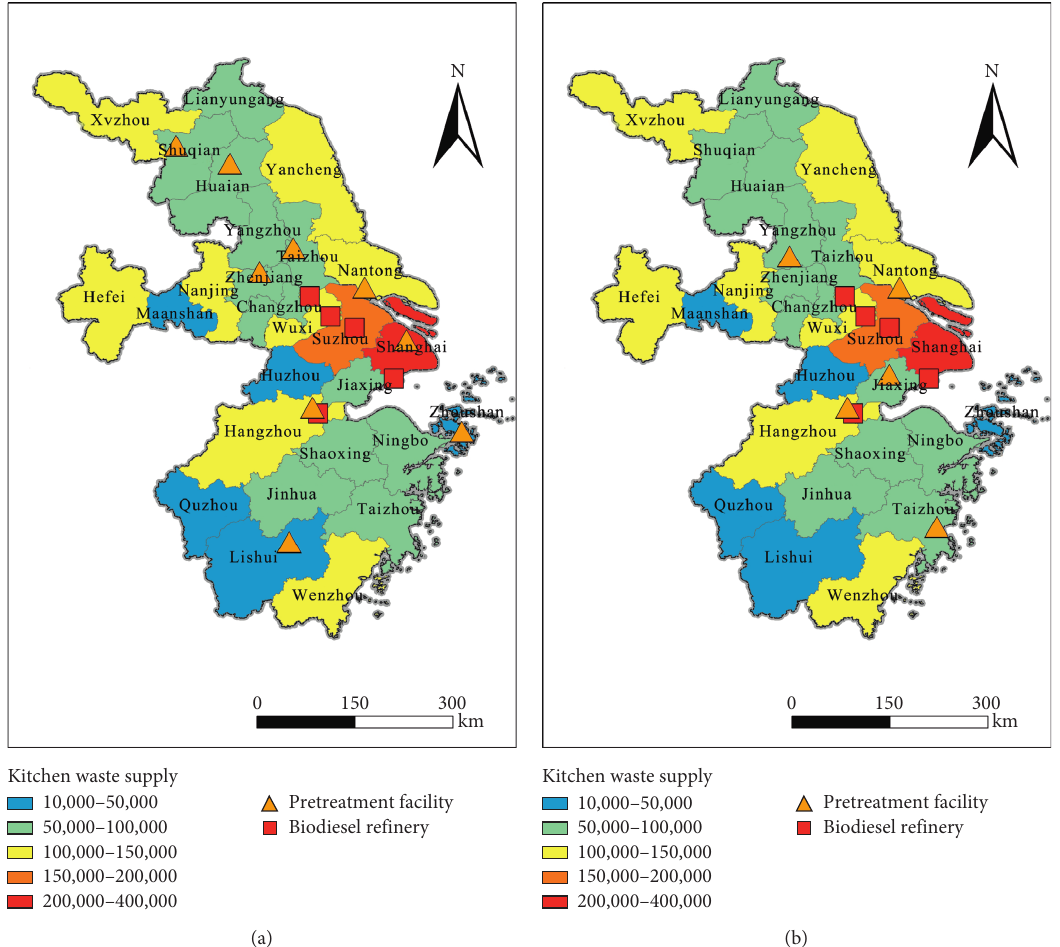
Figure 10: Network structure sensitivity analysis of kitchen waste pretreatment rate. (a) Pretreatment rate of 5.5%. (b) Transportation rate of